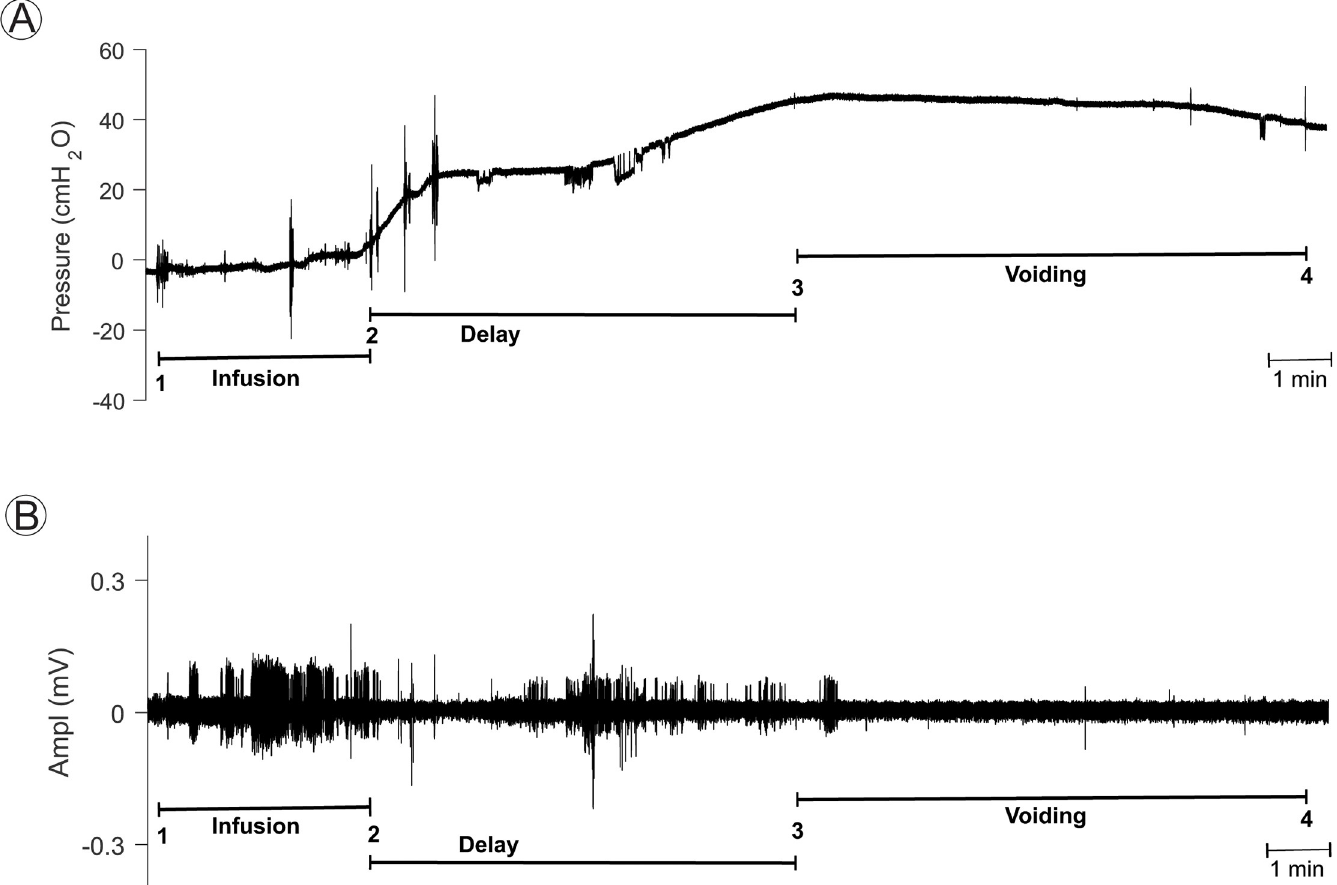
Fig 5. Combined cystometrogram (CMG) and external urethral sphincter (EUS) EMG recordings under propofol anesthesia in a 23.2 year old female rhesus macaque of the aged cohort. A. CMG recordings were performed after placement of a transurethral triple-lumen bladder catheter and emptying of bladder. Note gradual increase in bladder pressure from baseline to target of about 25 cm H 2 O in response to infusion of 145 ml saline, followed by a delay, and later onset of a reflex bladder contraction, shown by an increase in bladder pressure and subsequent voiding. Voided volume was 114 ml and voiding efficiency was 79%. B. EAS EMG recordings were obtained concurrently with the CMG recordings in A . Note EUS EMG activity during infusion of saline using the fill port of the transurethral bladder catheter. There is decreased EUS EMG activity during the early portion of the delay period, but the EUS EMG activity increased in response to the onset of the bladder contraction, consistent with the guarding reflex. The EUS EMG activity was quiescent during the voiding phase. For both A and B , onset and end of saline infusion is indicated by (1) and (2), respectively, and onset and end of voiding is indicated by (3) and (4), respectively.